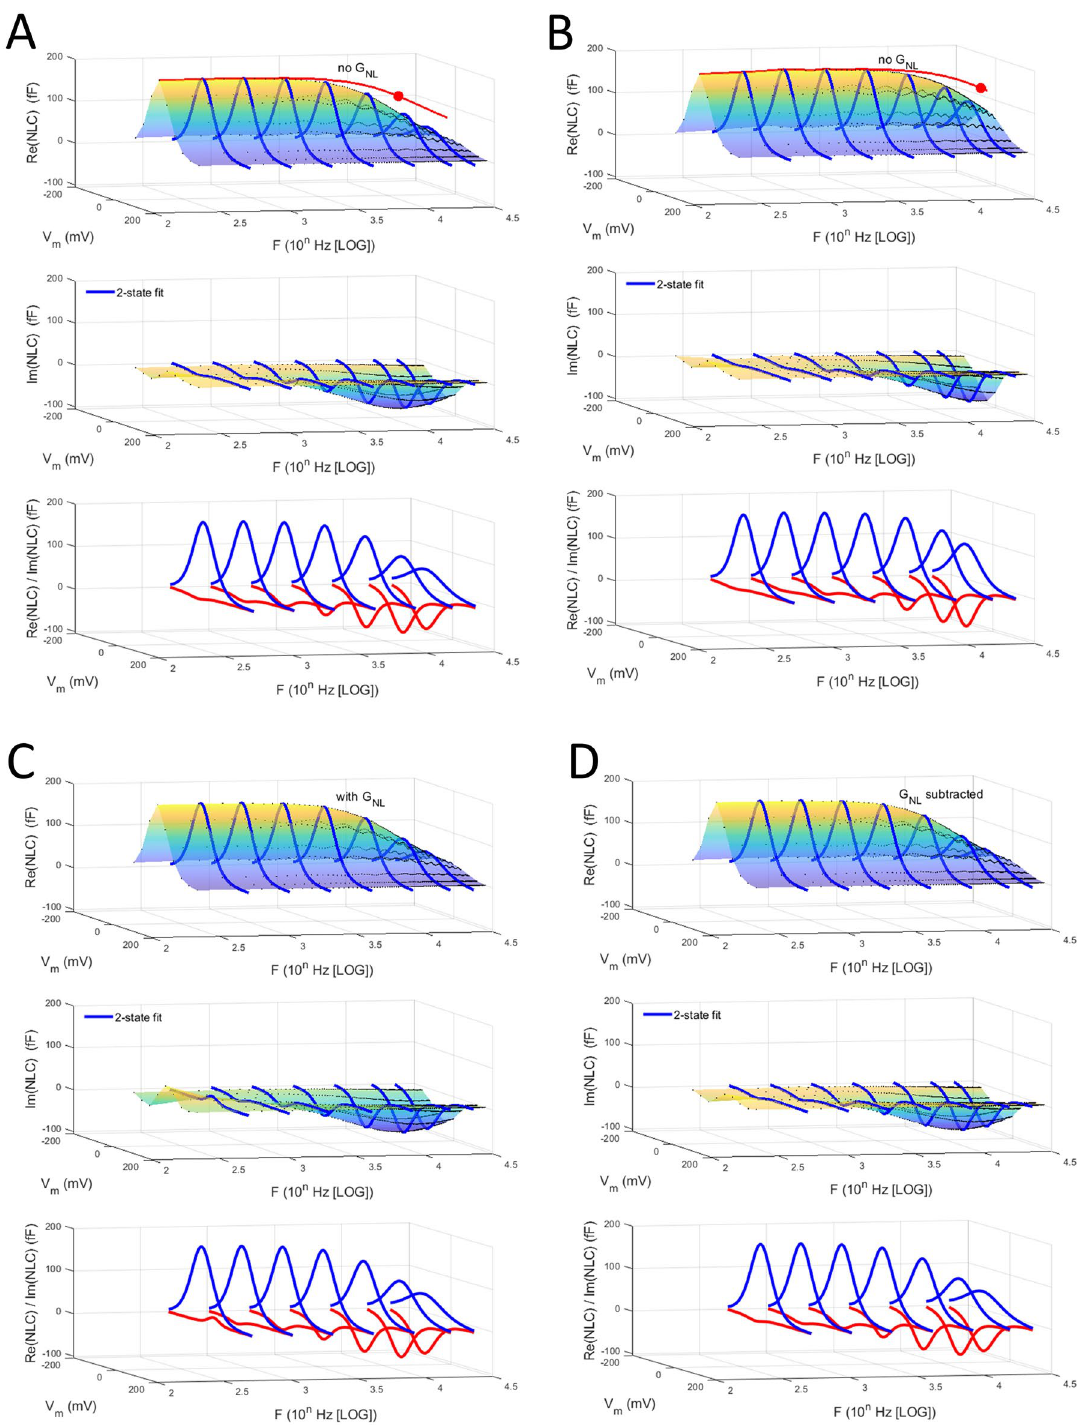
Figure 3. Real and imaginary components of NLC generated by a solely voltage-dependent 2-state kinetic model (see “Results” section for details), with characteristic cut-offs at V h dependent on transition rates, α and β. (A) simulations with both rate constants (α 0 = β 0 ) equal to 45,000/s, and (B) with both rate constants equal to 90,000/s. In addition to the complex component plots, the absolute magnitude of NLC at V h is shown with red lines. The rates provide characteristic time constants (tau = 1/(α 0 + β 0 ); 11.1 μs and 5.6 μs, respectively) for charge movement in the time domain at the potential V h . In the frequency domain, the cut-off frequency at V h is defined as F c = 1/(tau × 2π), 14.3 and 28.6 kHz, respectively. The filled red circles mark the cut-off frequencies. (C) Same model as in (A) , but with an additional nonlinear DC conductance (designed to be like that in our patch data) which distorts the low frequency response of the imaginary component. (D) After removing the DC conductance with the approach detailed in the “Methods” section, the response is essentially the same as in (A) , where no DC conductance is included, confirming the validity of our approach to remove any residual DC conductance in our patch